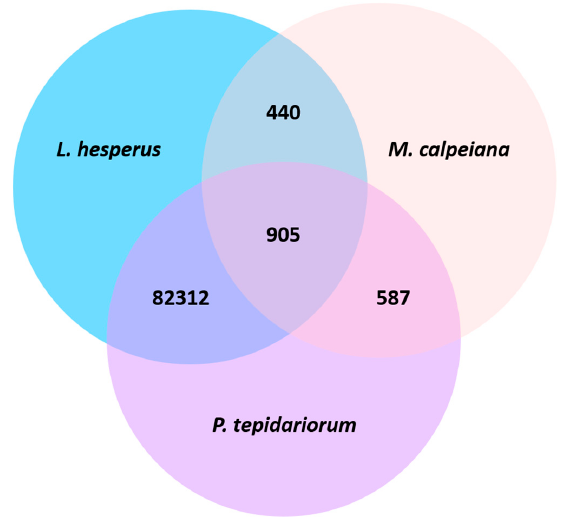
Figure 4. Transcripts overlapping in the ovarian transcriptomes among the three arachnids L. hesperus , Macrothele calpeia na , and Parasteatoda tepidariorum . Table 1. Arthropod fecundity-related genes present in the L. hesperus ovarian transcriptome. Gene.